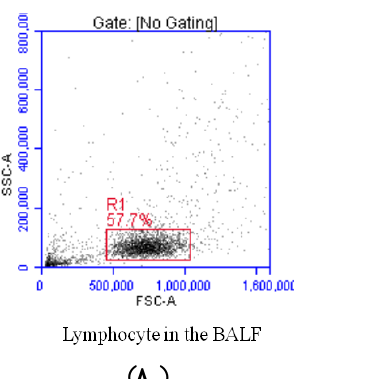
Figure 2. Representative plots of Th17 and Treg cells in sarcoidosis patients’ BALF by flow cytometry ( A , B , C , D ). ( A ) Physical parameter (forward scatter and side scatter) of lymphocytes in BALF; ( B ) Physical parameter (side scatter) and CD4 expression of lymphocytes in BALF; ( C ) Representative dot plots showing CD4 + T cells producing IL-17A in sarcoidosis patients’ BALF; ( D ) Representative dot plots showing CD4 + T cells producing CD25 and Foxp3 in sarcoidosis patients’